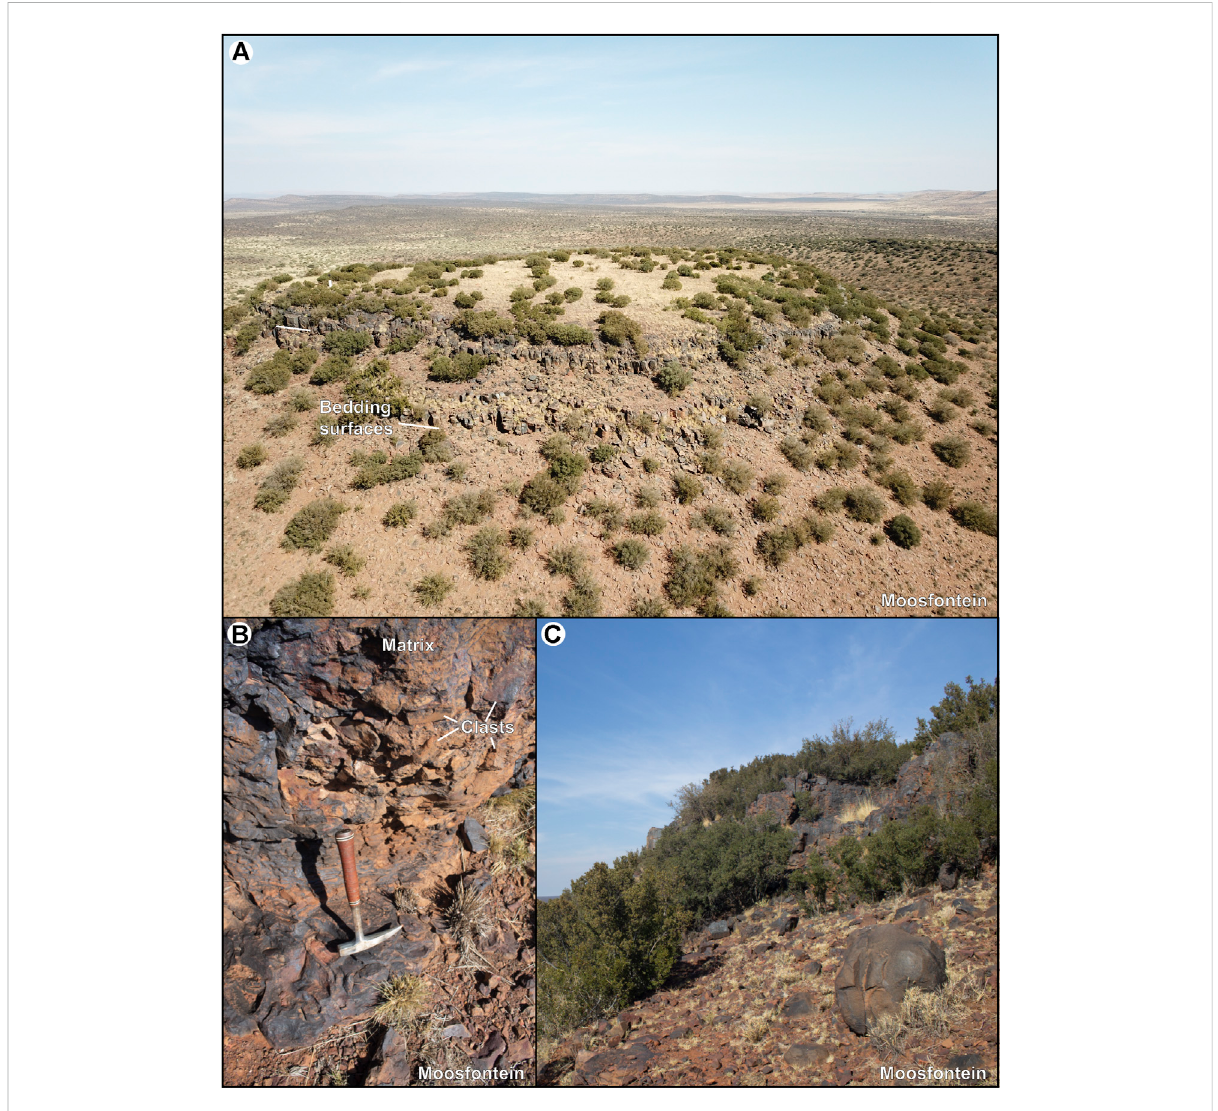
FIGURE 4 Outcrop character and facies at Moosfontein Farm. (A) Aerial photograph taken with aDJI Mavic Pro UAV, showing the regionally fl at character of the stratigraphy in the Makganyene Formation. (B) Typical exposure of ferruginous diamictite, containing a range of angular to rounded clasts. (C) Typical weathering